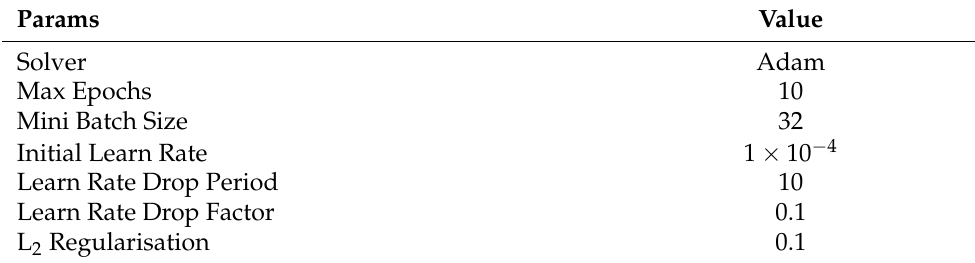
Table 1. Hyperparameters settings for CNNs